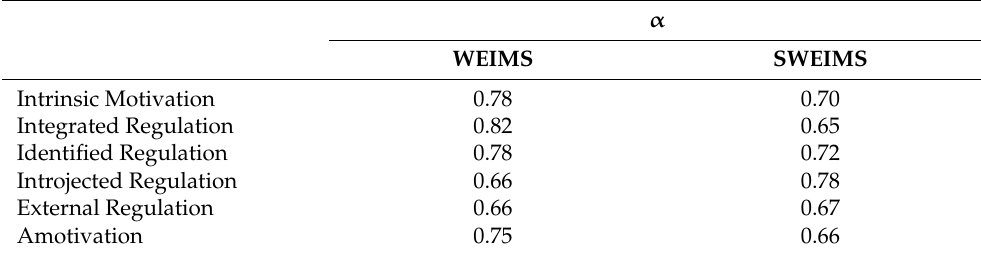
Table 3. Internal Consistencies for the Original Work Extrinsic and Intrinsic Motivation Scale (WEIMS) Subscale Scores and the Short Work Extrinsic and Intrinsic Motivation Scale (SWEIMS) Subscale Scores (103 Hospitality